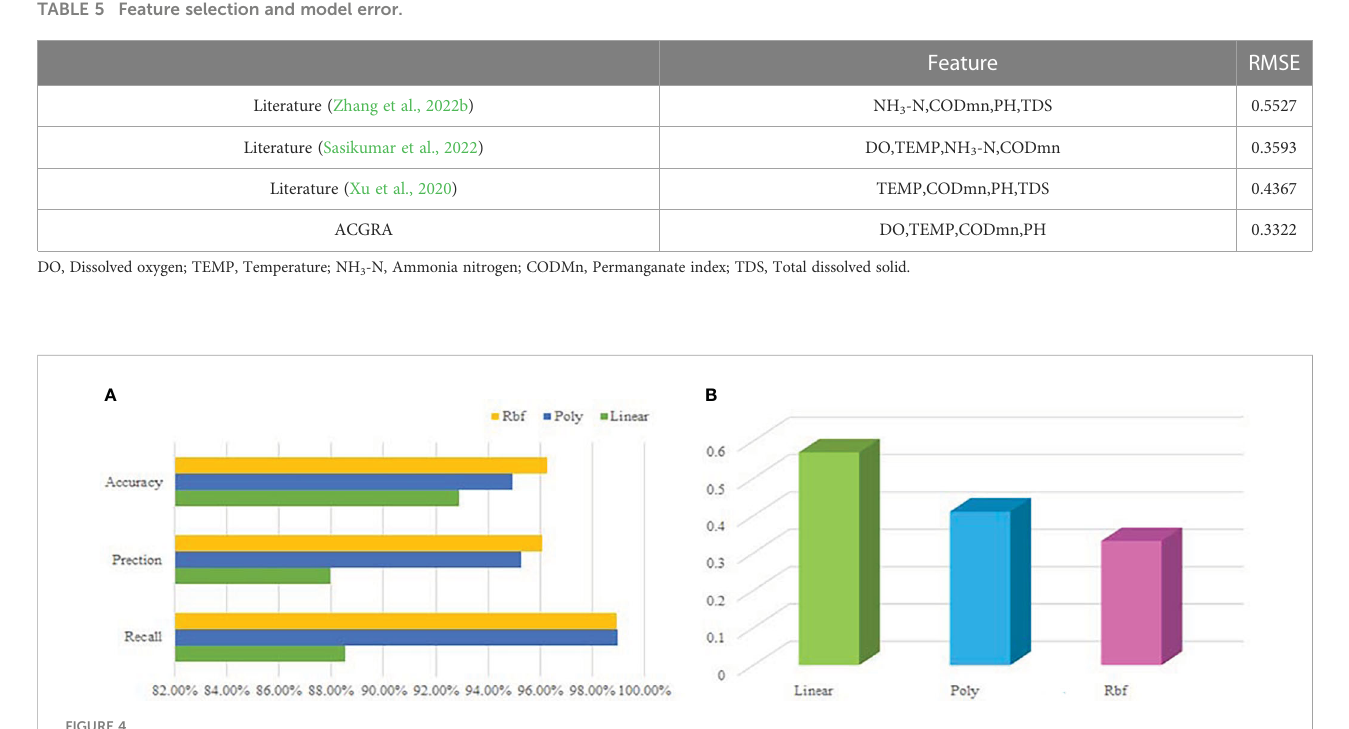
TABLE 5 Feature selection and model error.